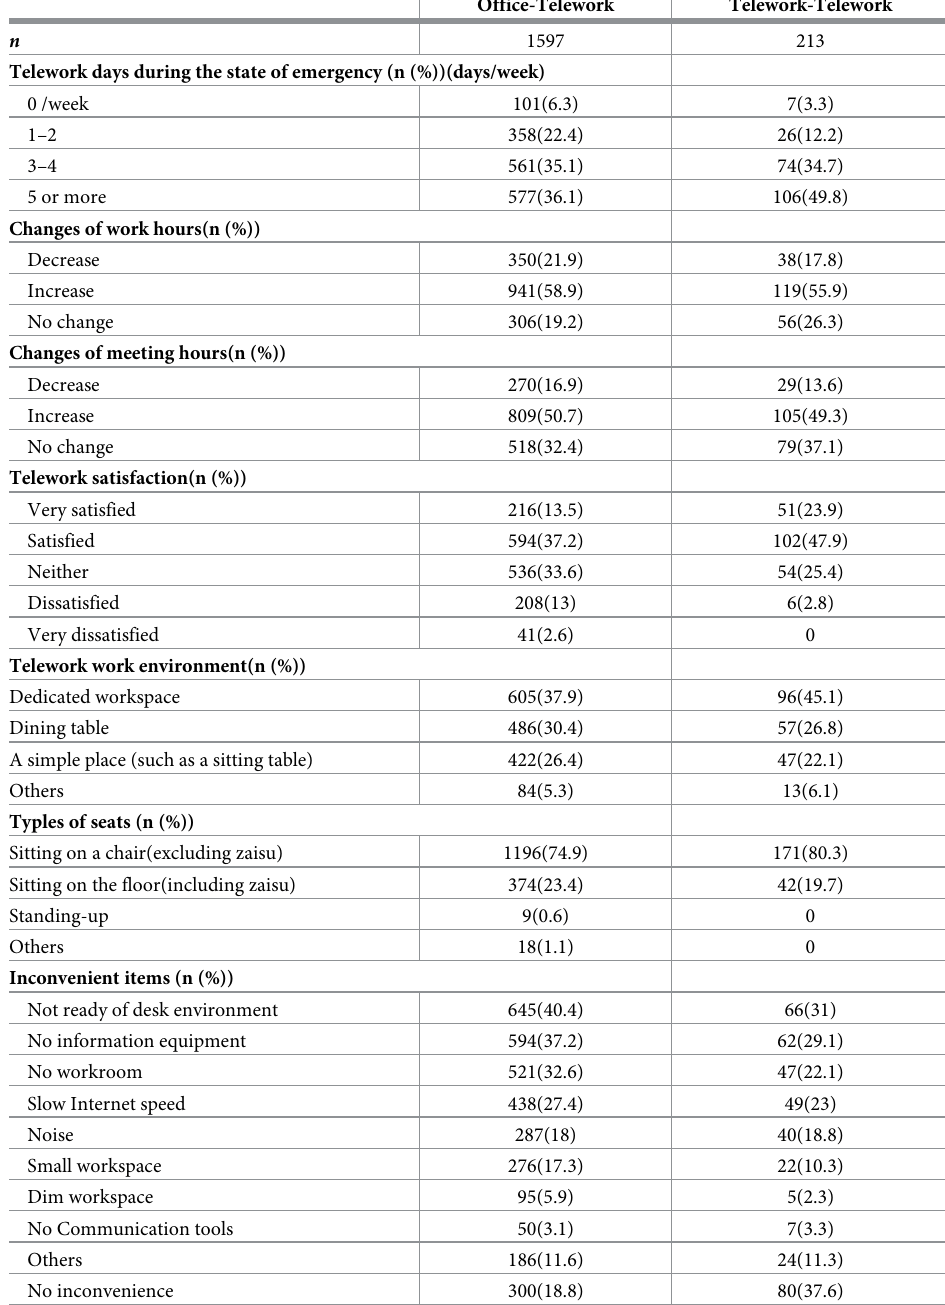
Table 2. Characteristics of teleworkers during the COVID-19